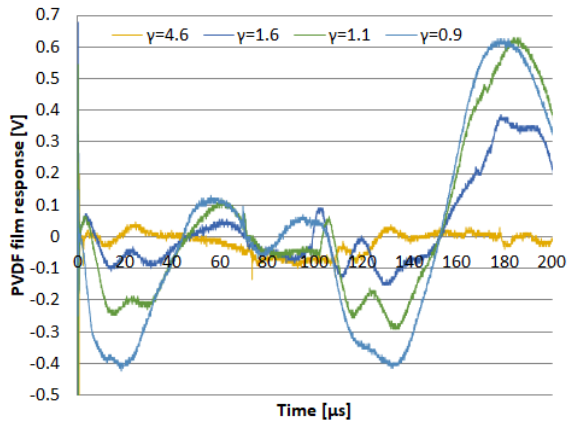
Fig. 8. Voltage signal measured on the PVDF